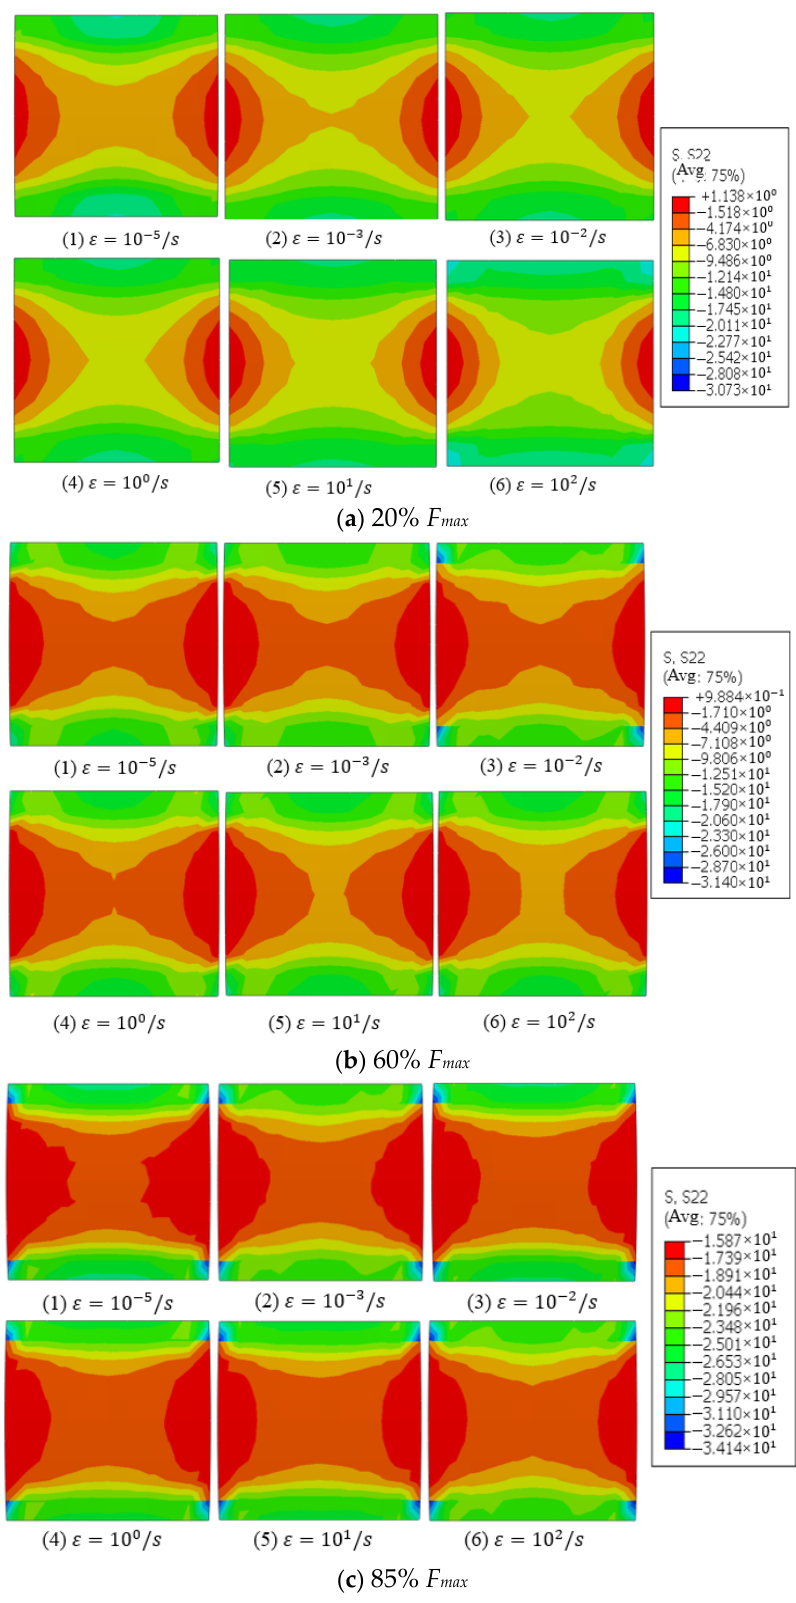
Figure 9. The stress cloud diagram under different loading stages. Considering the stress recorded by load sensor is equal to the reaction force of load- ing plate, thence the DIF values of different strain rates can be expressed as